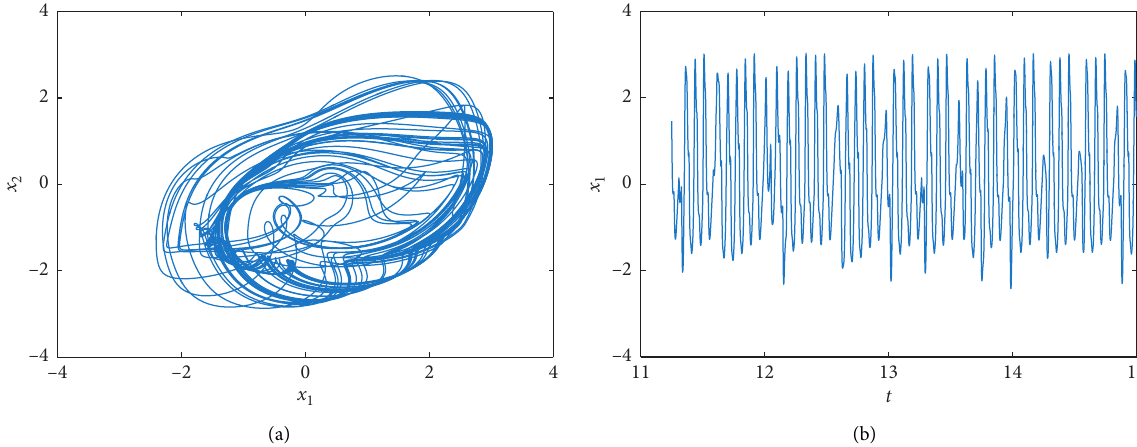
Figure 7: Phase portrait on plane ( x � 46. when P 1